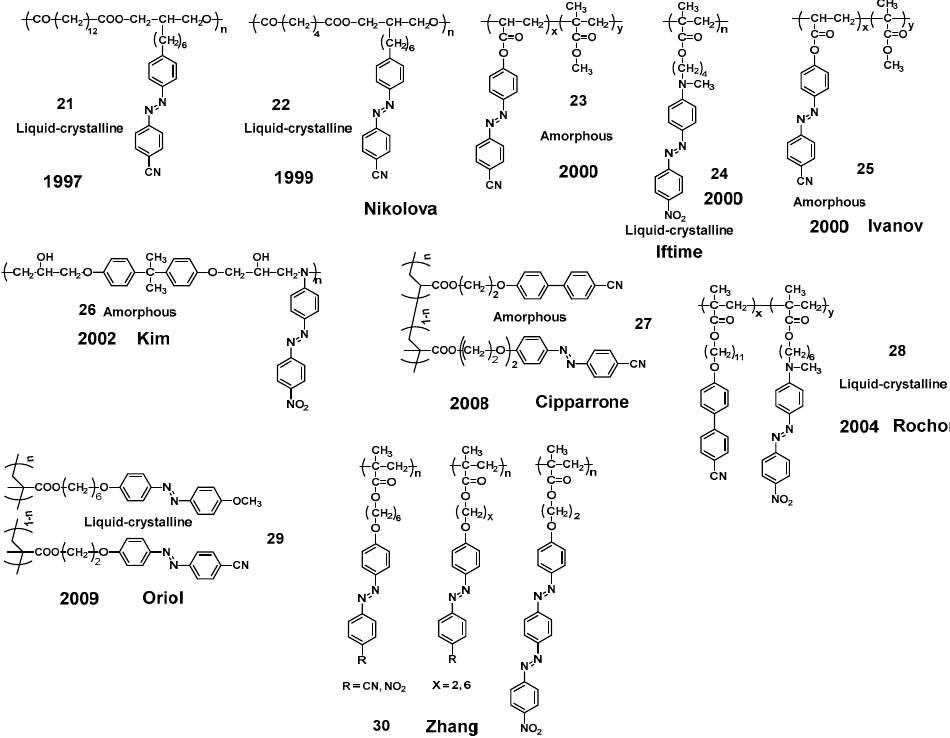
Figure 11. The chemical structures of achiral Azo-polymers 21, 22, 23, 24, 25, 26, 27, 28, 29 and 30.